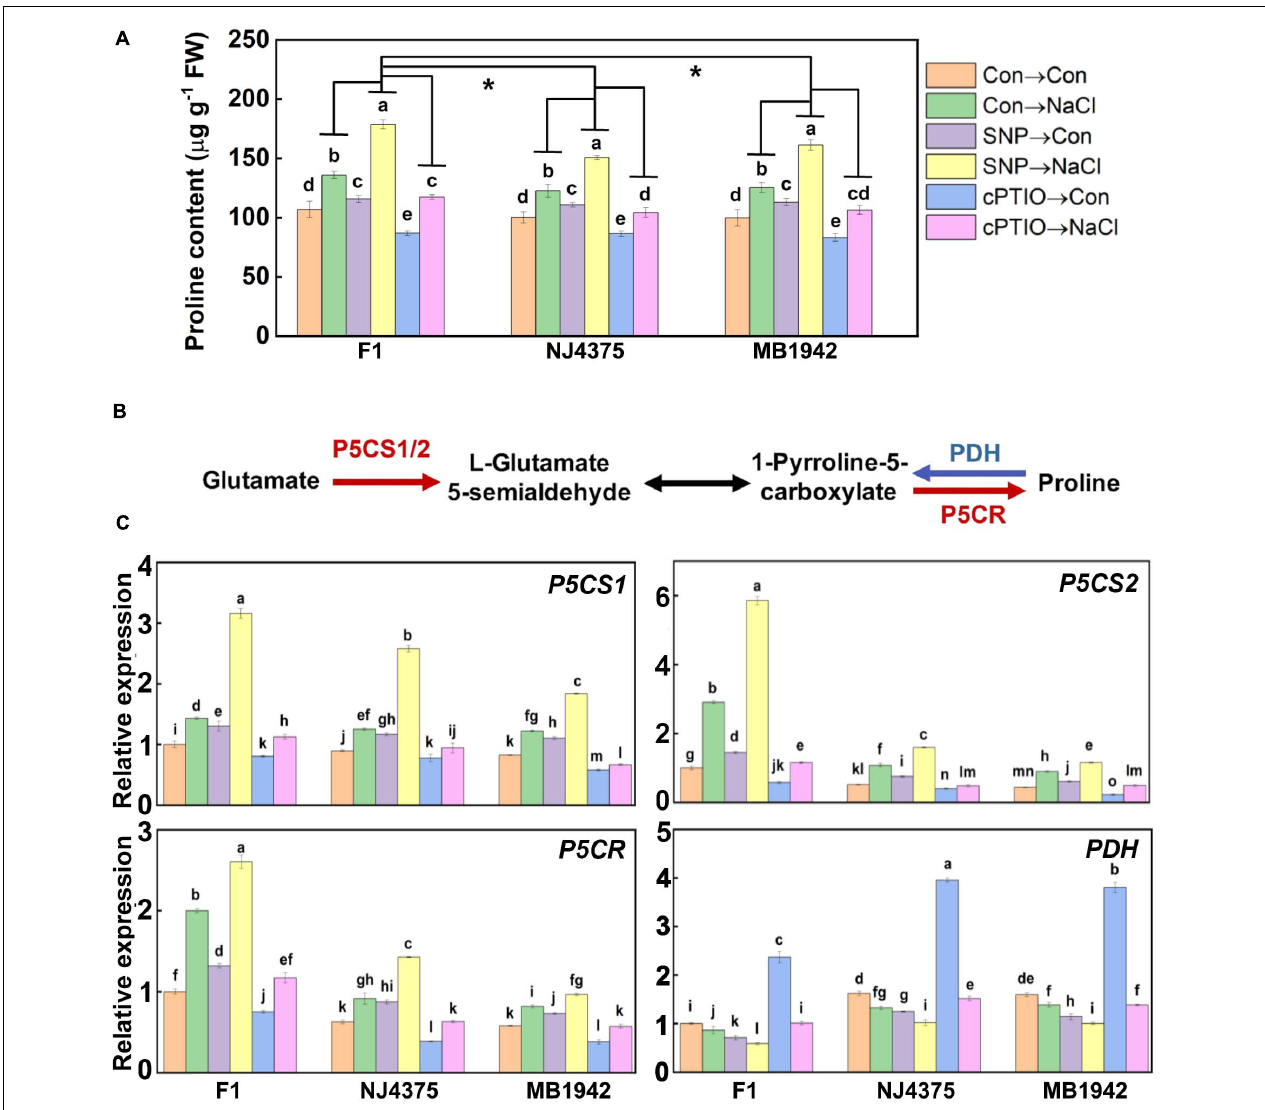
FIGURE 6 | The involvement of NO in the regulated proline biosynthesis. (A) Proline content was detected after treatments for 14 days. (B) After treated for 3 days, the proteins were extracted from the leaf tissues. Proline biosynthesis-related proteins were identified by LC-MS/MS. Compared with the parental lines, the up-regulated proteins associated with NO in the hybrid, including delta-1-pyrroline-5-carboxylate synthase A (P5CS1), delta-1-pyrroline-5-carboxylate synthase B (P5CS2), and pyrroline-5-carboxylate reductase (P5CR), are shown in red, and the down-regulated protein [proline dehydrogenase (PDH)] is shown in blue (data obtained from Supplementary Table 2 ). (C) After treated for 1 day, the expression profiles of the corresponding genes in the leaves of F1 and two parents were analyzed by qPCR. Values are the means ± SD for three independent experiments. For panel (A) , bars with different letters represent significant differences among treatments in a genotype (one-way ANOVA, P < 0.05, Duncan’s multiple range test), and the asterisk indicates significant difference between genotype × treatment interactions (two-way ANOVA, P < 0.05, Student’s t test). For panel (C) , bars with different letters represent significant differences (one-way ANOVA, P < 0.05, Duncan’s multiple range